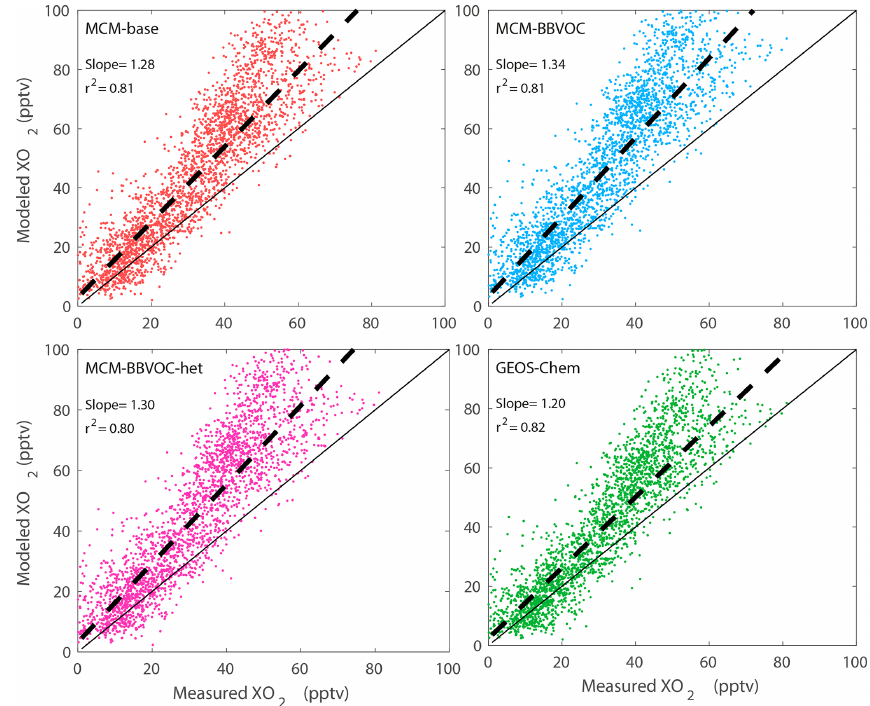
Figure 7. Comparison of all daytime XO 2 observations (09:00–21:00MDT) to modeled XO 2